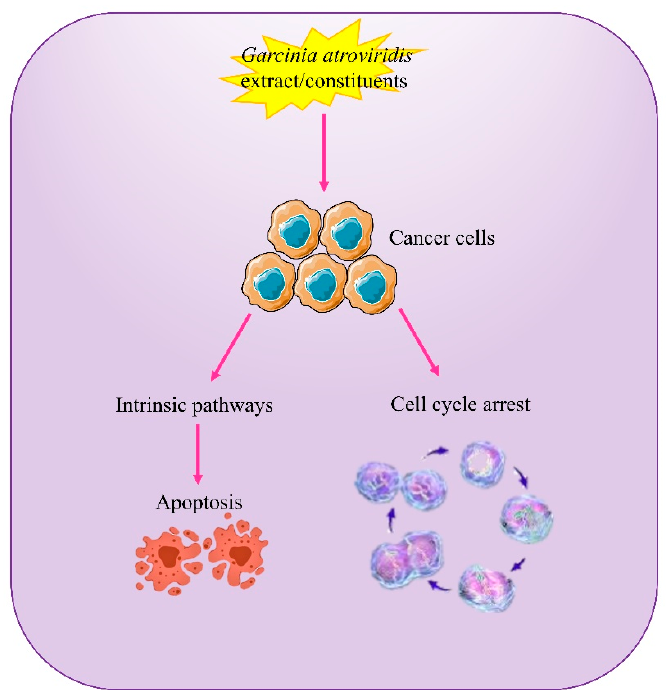
Figure 6. Schematic illustration of the probable anticancer mechanisms of action of G. atroviridis extracts or its constituents.